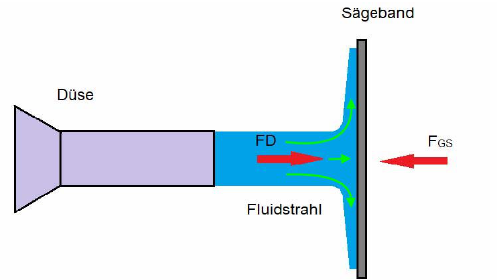
Figure 3. Simplified representation of the water jet on the bandsaw based on